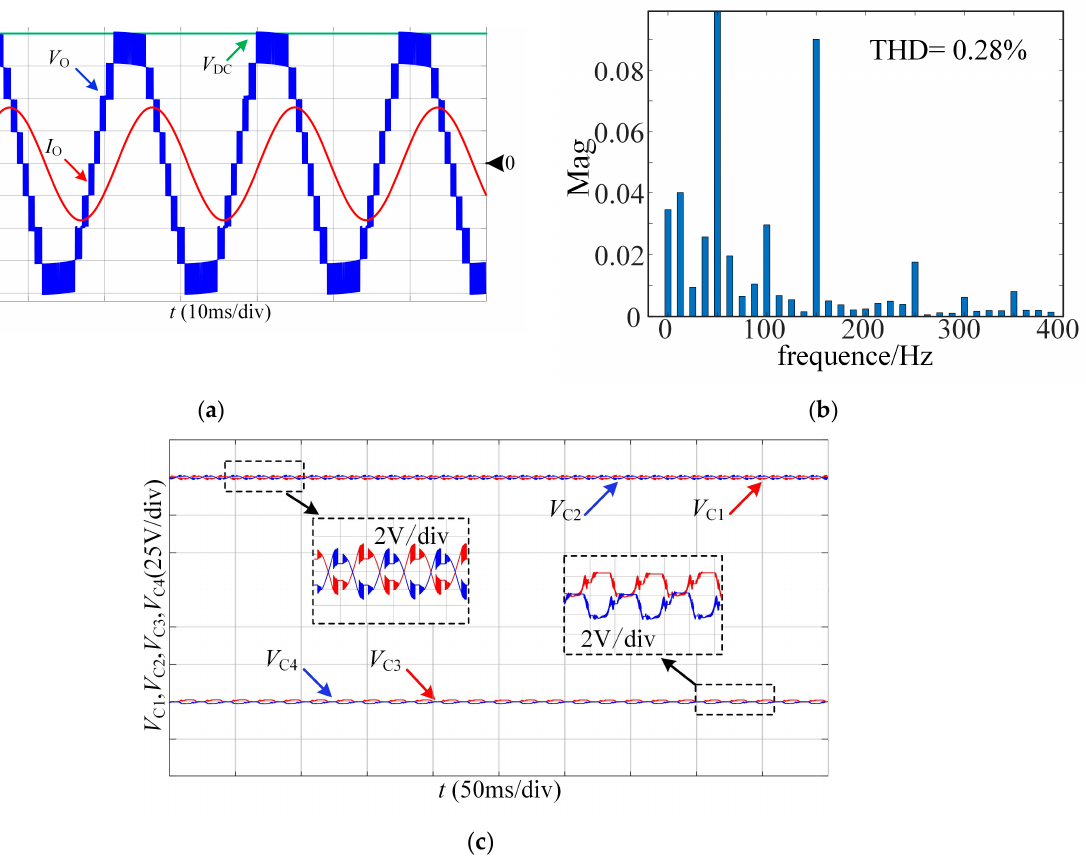
Figure 9. Simulation waveforms of the proposed topology in the steady-state. ( a ) Bus voltage out- put voltage and output current simulation waveform; ( b ) Output current FFT analysis results; ( c ) Simulation Waveforms of dc-link Capacitor Voltage and Suspended Capacitor Voltage.